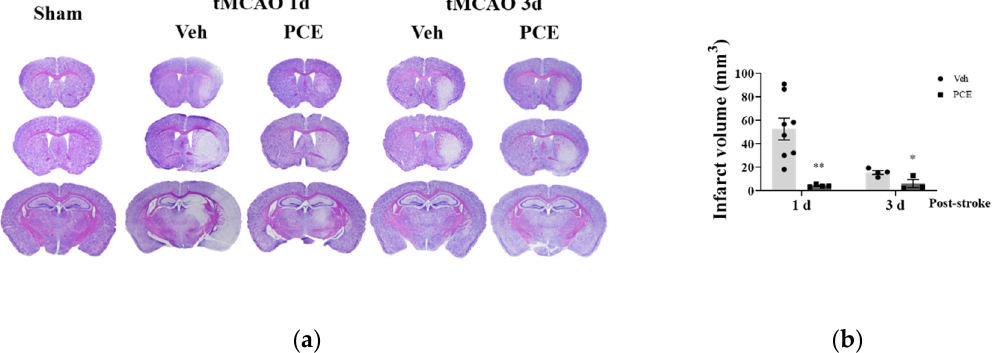
Figure 5. Pretreatment PCE group has reduced infarct volume in ischemic stroke mouse brain. ( a ) Representative cresyl violet-stained sections of mouse brain on days 1 and 3 post-stroke. ( b ) Graph displays the quantification of measured infarct volumes. PCE treatment reduced the infarct volume by approximately 90.6% and 60.1% compared with the vehicle group after 1 and 3 days post-tMCAO, respectively (1d, n = 8; 3d, n = 4). Values are mean ± SEM. ** p < 0.01, * p < 0.05, compared with the vehicle-treated tMCAO group, determined by Student’s t